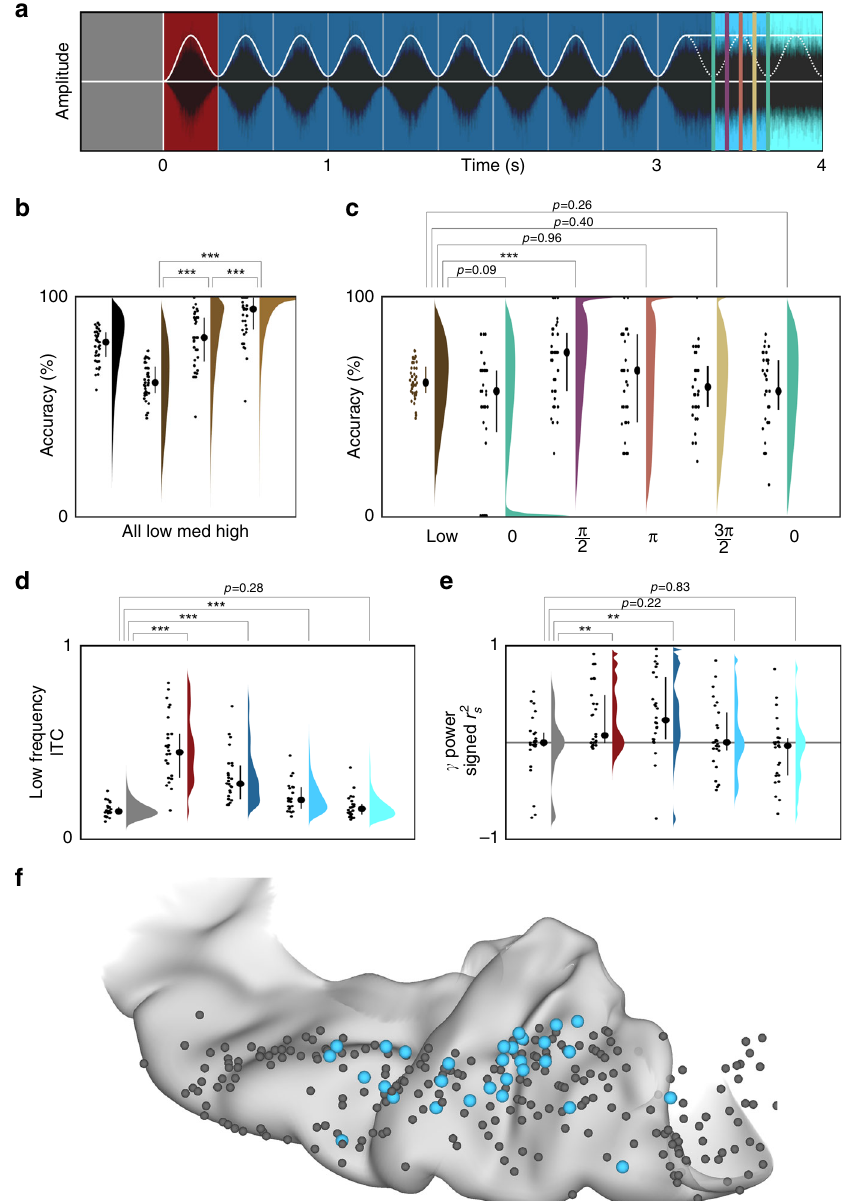
Fig. 4 Prediction of timing in auditory cortex. Low-frequency phase in early auditory cortex shows evidence of predictive encoding. a The stimulus was divided into fi ve intervals: baseline (gray), onset (red), sustained (dark blue), early prediction (medium blue), and late prediction (light blue). Crucially, there is no modulation of white noise amplitude in either of the prediction intervals. Tones were presented in 50% of trials at one of three intensities and one of fi ve temporal delays. b Performance accuracy at each intensity level, grouped across delay categories. For each condition, the raw data (left), interquartile range (middle), and kernel density estimate (right) are shown. Signi fi cance was determined in d , e with the Wilcoxon signed-rank test (* p < 0.05, ** p < 0.01, *** p < 0.001). c Accuracies in the low-intensity condition separated by temporal delay. Behavioral performance was uniquely increased at the fi rst “ missing ” acoustic pulse edge — coincident with the phase reset we observe in neural low-frequency response. d , e The same electrode group shown in Fig. 1b was used for the following analyses. Violin plots demonstrating engagement of low-frequency phase and high-gamma power during each interval. The sustained response in low-frequency phase was measured as average ITC; in high-gamma power, it was measured as a signed r 2 from the Spearman ’ s correlation with a 3-Hz sine wave. Both low-frequency phase and high-gamma power were signi fi cantly engaged during the onset and sustained intervals ( p < 10 − 3 , p < 10 − 3 ; p = 0.0012, p = 0.0017), but only low-frequency phase remained signi fi cantly engaged during the fi rst prediction interval ( p < 10 − 3 ). f All electrodes on the supratemporal plane ( n = 349) were evaluated for a signi fi cant sustained response during the rhythmic stimulus followed by low-frequency phase reset in the fi rst prediction interval. Those with a signi fi cant predictive effect are shown in blue ( n = 36), predominantly found in